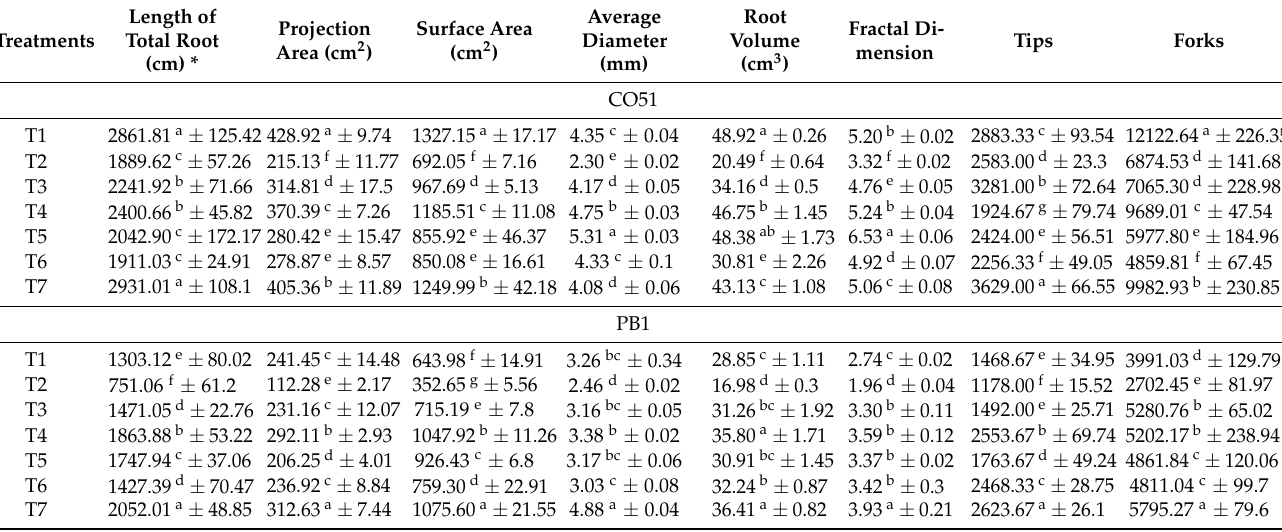
Table 3. Effects of microbial inoculation on root architectural